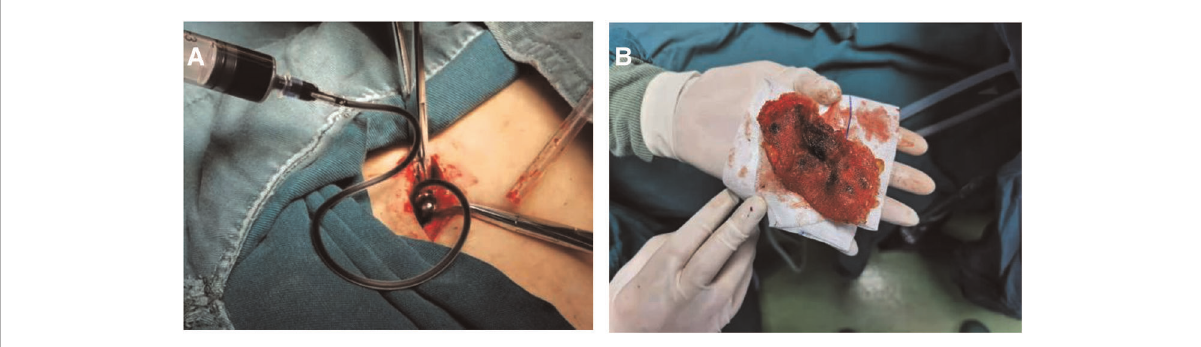
FIGURE 4 Surgical procedure of infected mesh removal using methylene blue. ( A ) Methylene blue was injected in sinus on incision site. ( B ) Infected Kugel patch was isolated and removed.